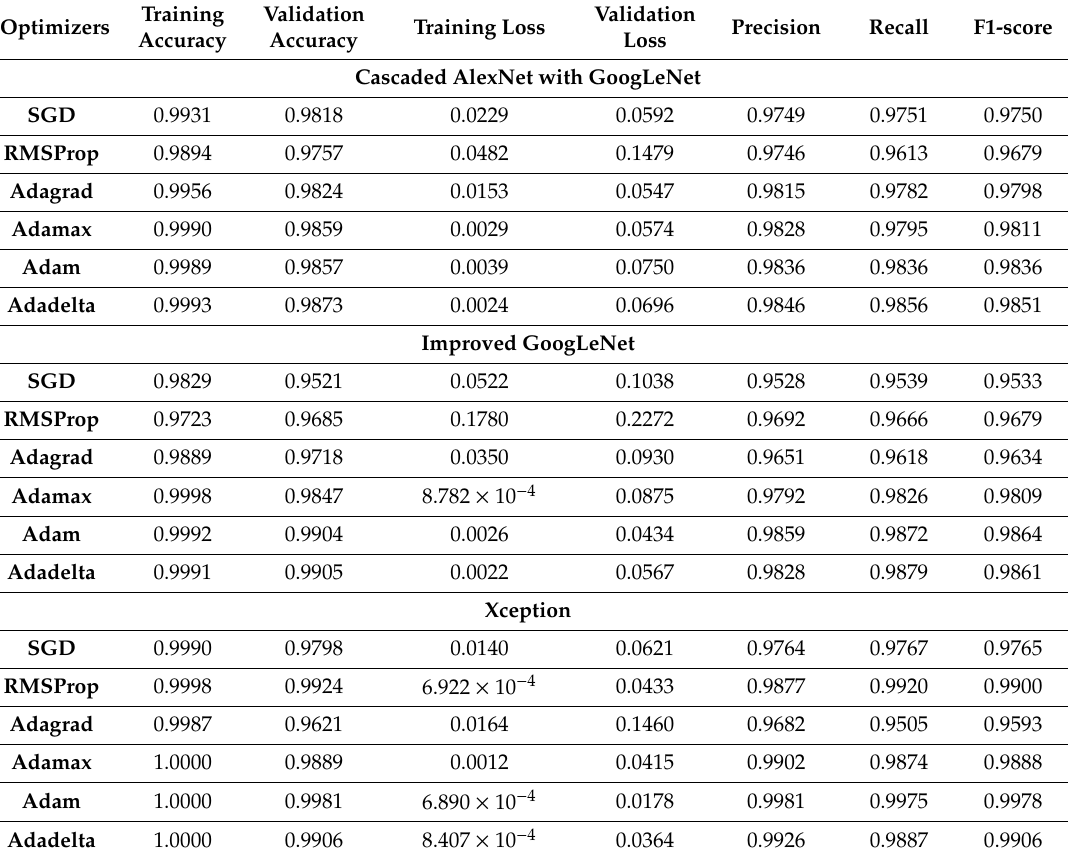
Table 3. Performance of deep learning optimizers applied to train cascaded AlexNet with GoogLeNet, Improved GoogLeNet, and Xception